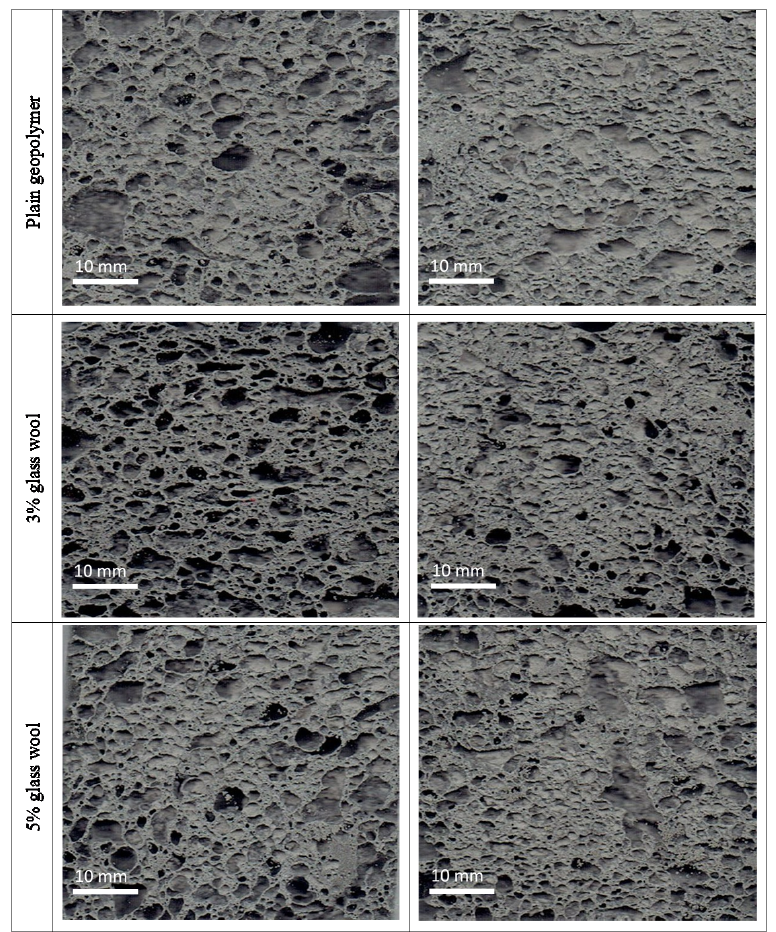
Figure 8. The porous structure of the produced geopolymers.